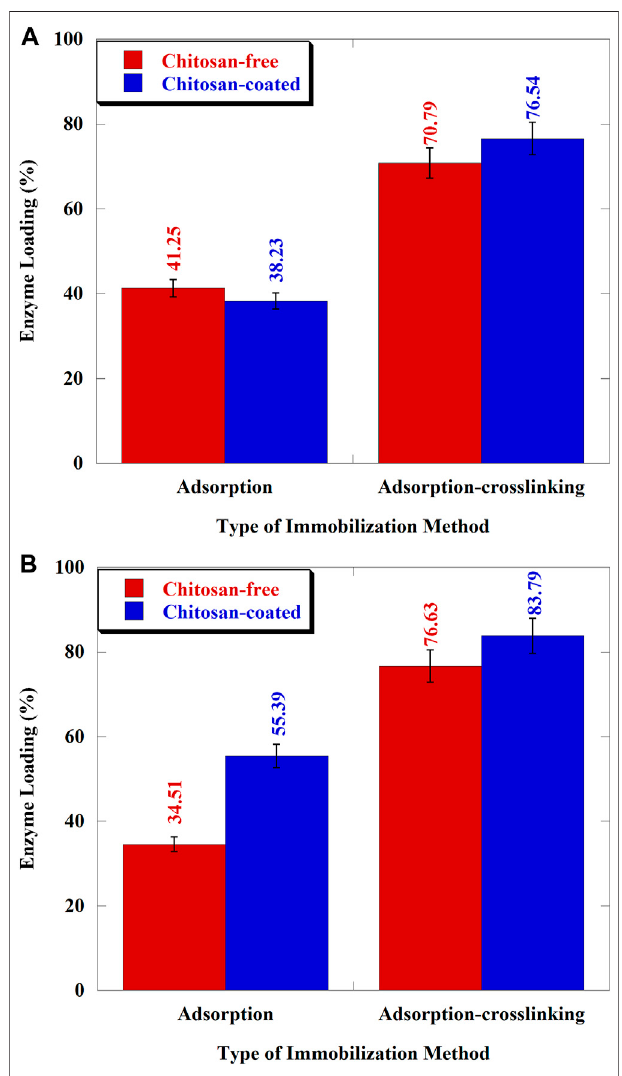
FIGURE 4 | Enzyme loading of Aspergillus niger lipase immobilized on resins: (A) XAD-7HP and (B) MP-64.